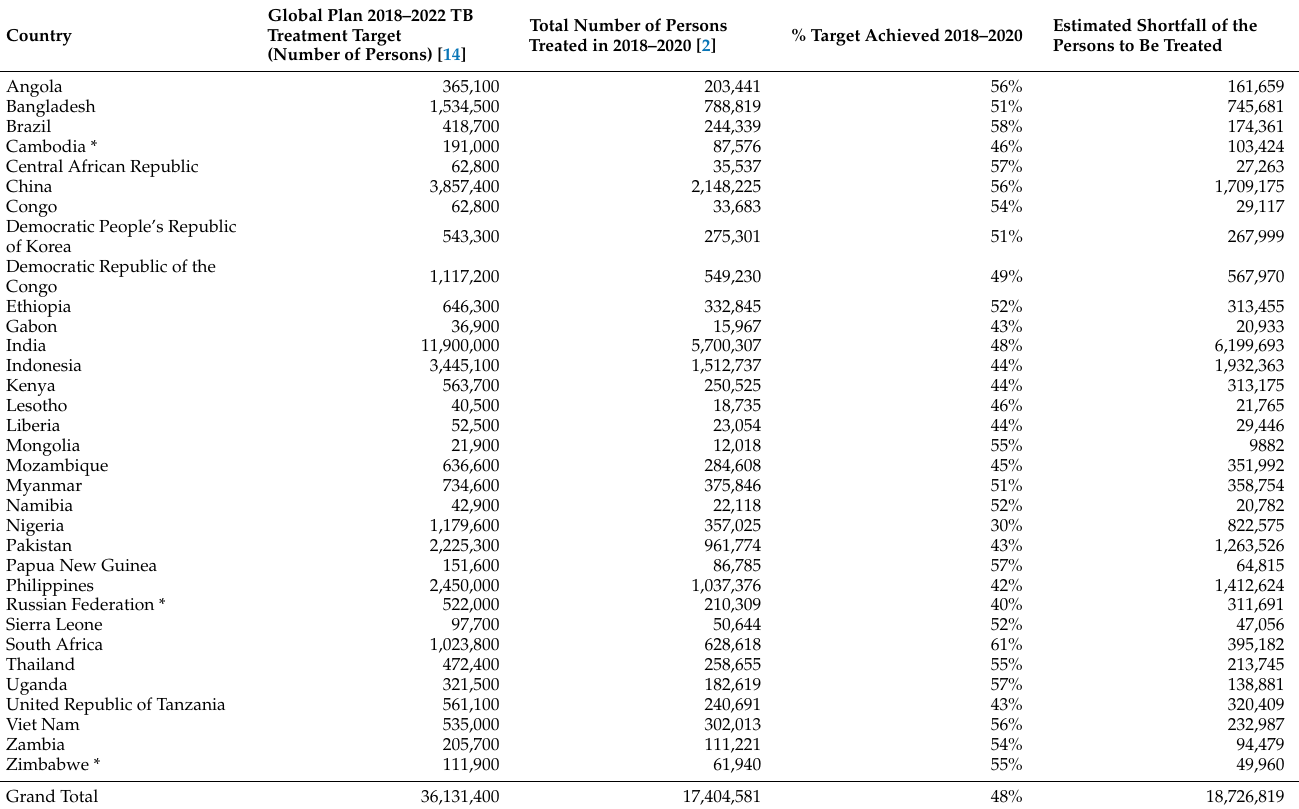
Table 1. Countries’ TB treatment targets and the estimated number of people remaining to be treated to achieve the UNHLM TB treatment targets in 30 high-TB burden countries and 3 countries on the global TB watchlist.